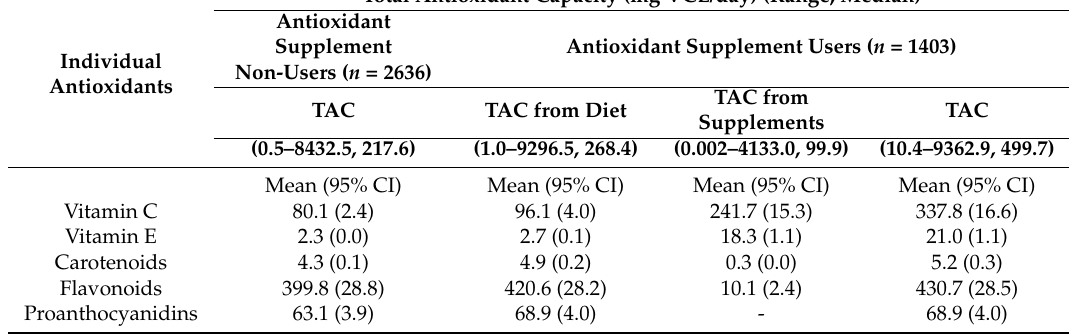
Table 2. Total antioxidant capacity (TAC) from individual antioxidants by antioxidant supplement users and non-users among U.S. adults in the NHANES 2007–2012 ( n = 4039) 1